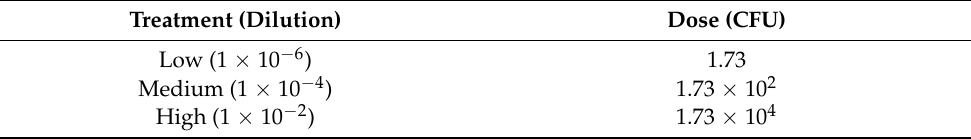
Table 1. Treatment dilutions and corresponding mean colony forming units (CFU) dose of 6/85 Mycoplasma gallisepticum for each 50 µ L solution volume administered by in ovo injection to layer embryos at 18 days of